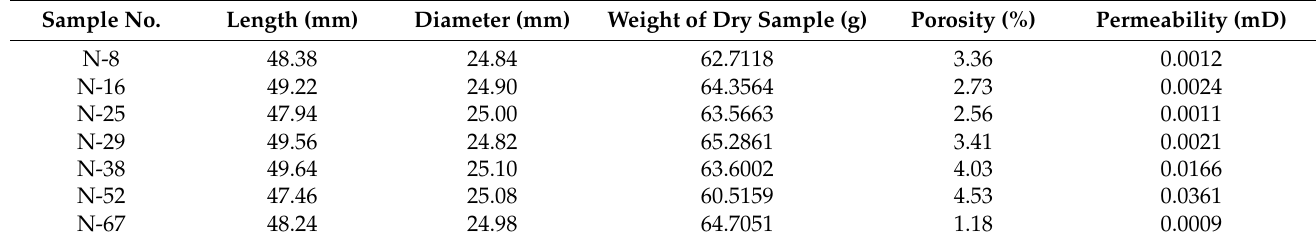
Table 2. The basic physical properties of imbibition experimental samples. Sample